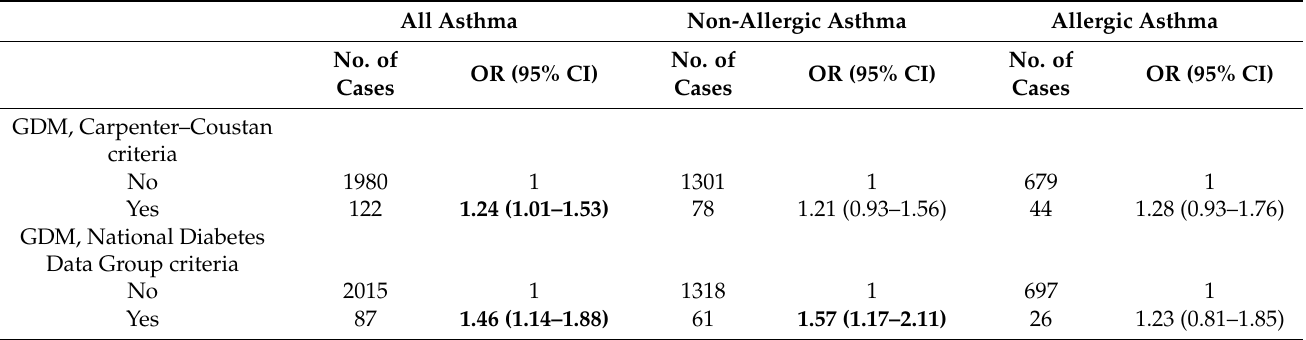
Table 3. Associations of GDM with incidence of allergic and non-allergic asthma in